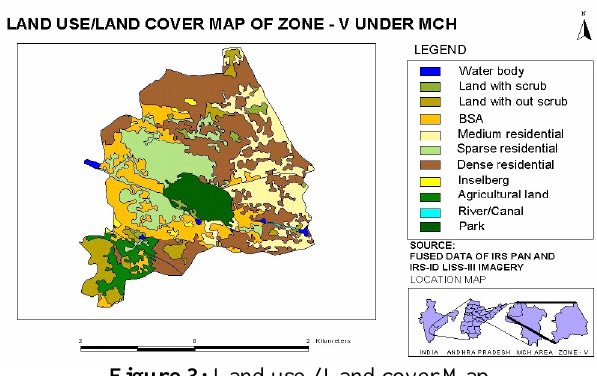
Figure 3: Land use / Land cover Map